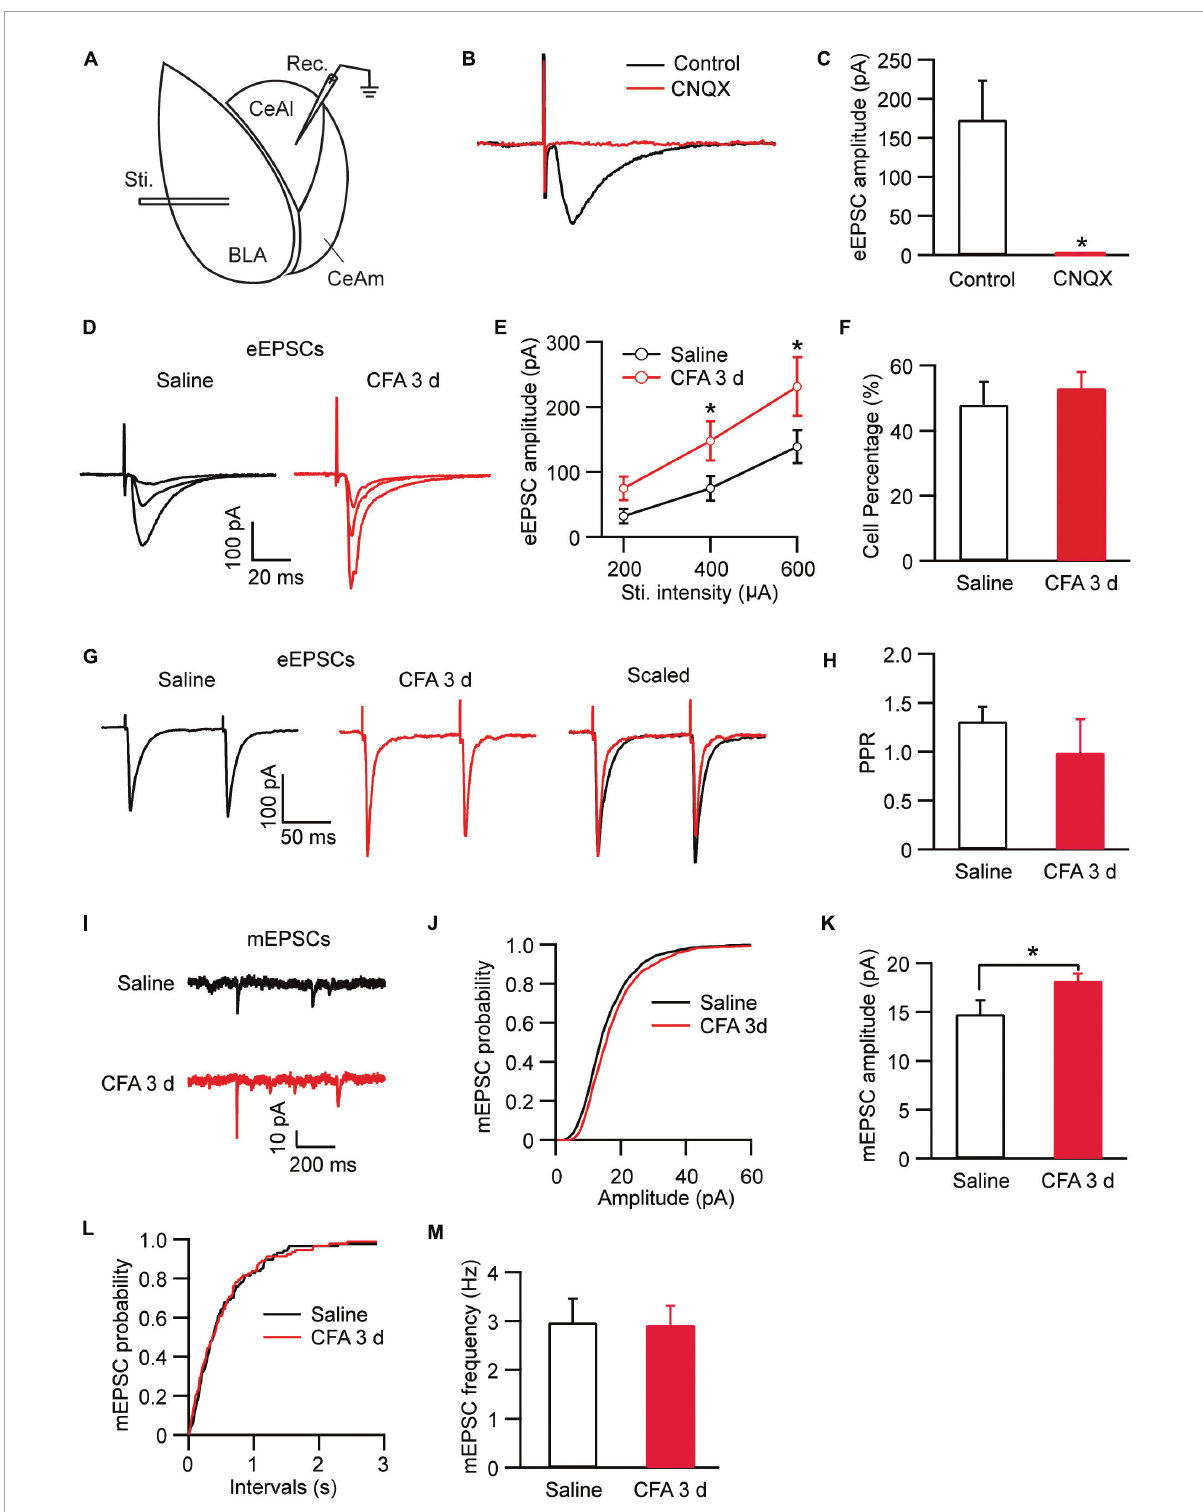
FIGURE2 Persistent pain activates the BLA–CeAl pathway. (A) A schematic of recording configuration in amygdala with electrical stimulation (Sti.) in BLA and whole-cell recording (Rec.) in CeAl. (B,C) Sample traces (B) and group data (C) of evoked EPSCs (eEPSCs) in CeAl neurons before (control) and after application of CNQX (10 µ M), n = 7. (D,E) Representative traces (D) and group data (E) of eEPSCs evoked by various stimulation intensities in the saline- and CFA-injected rats ( n = 9–16 per group). (F) Percentage of CeAl cells displaying BLA-elicited eEPSCs in the saline and CFA groups. (G,H) Current traces (G) and group data (H) of eEPSC pairs evoked by two electrical stimuli (400 µ A, 100 ms interval) in the two rat groups. (I–M) Representative traces of miniature EPSCs (mEPSCs, I ), group data of mEPSC amplitude (J,K) and mEPSC frequency (L,M) in the saline and CFA groups. * p <